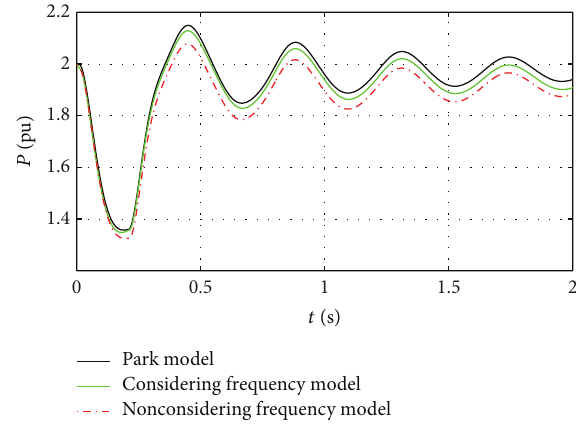
Figure 14: Active power of wind generator.